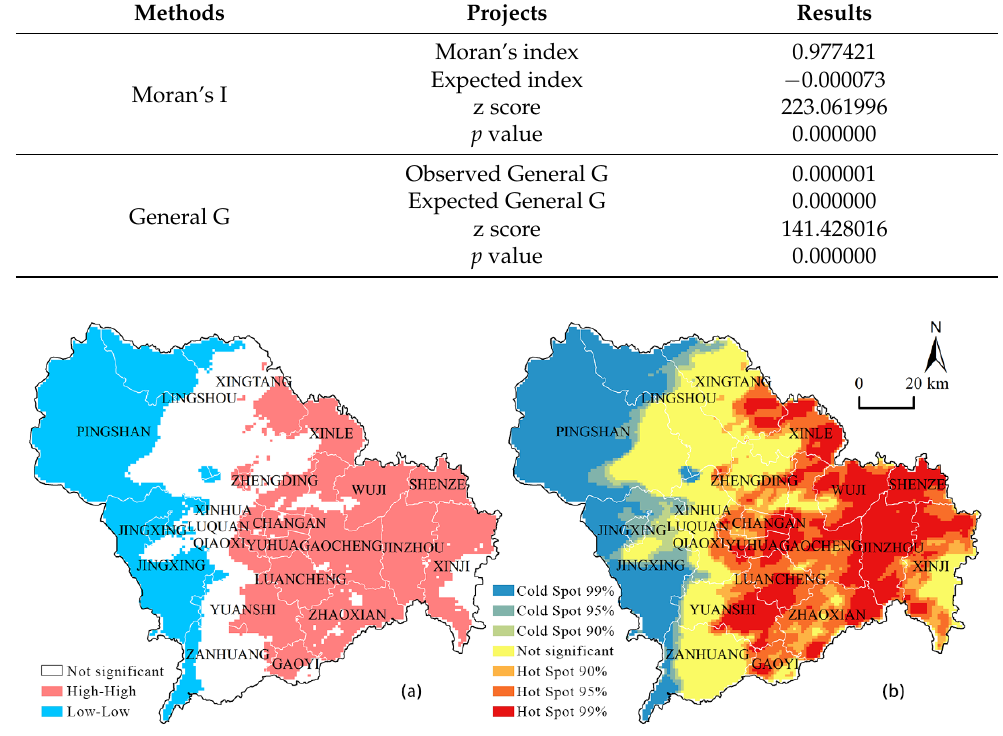
Figure 5. Clustering and hotspot analysis results: ( a ) Anselin local Moran results; ( b ) Getis–Ord-Gi* results.